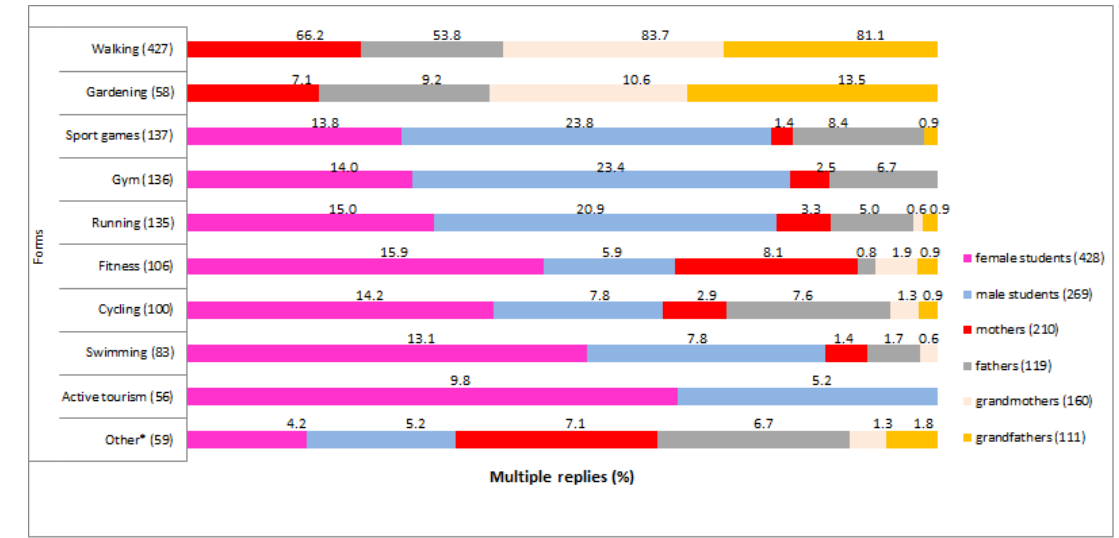
Figure 2. Physical activity patterns of students, their parents, and their grandparents (%). * Combat sports, dance, pole dance, horseback riding, tennis, table tennis, and badminton.